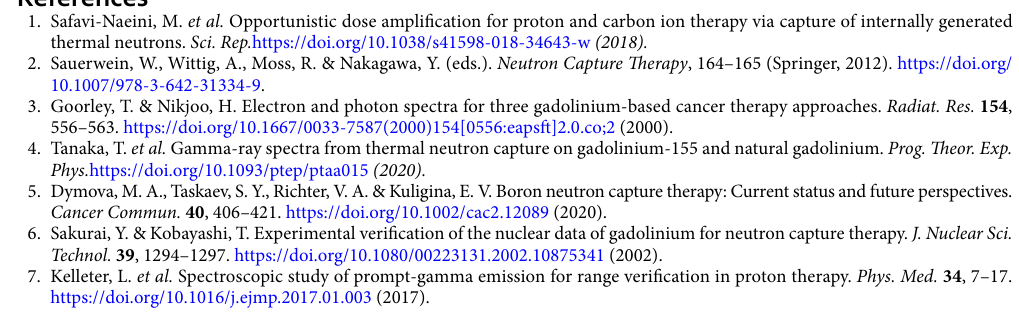
Figure 10. Sensitivity (upper plot) and R TF (lower plot) for events recorded in a detector shielded by different materials with high thermal neutron cross-section, following target irradiation by a carbon ion beam. In all plots, the red markers denote an unshielded detector, green cadmium shielding, blue gadolinium shielding ( 157 NCI only), black boron shielding ( Gd NCI only), and magenta hafnium shielding. In the upper plots in each subfigure, square markers ( (cid:31) ) joined by unbroken lines denote true positives, while cross markers ( × ) joined by dashed lines denote false